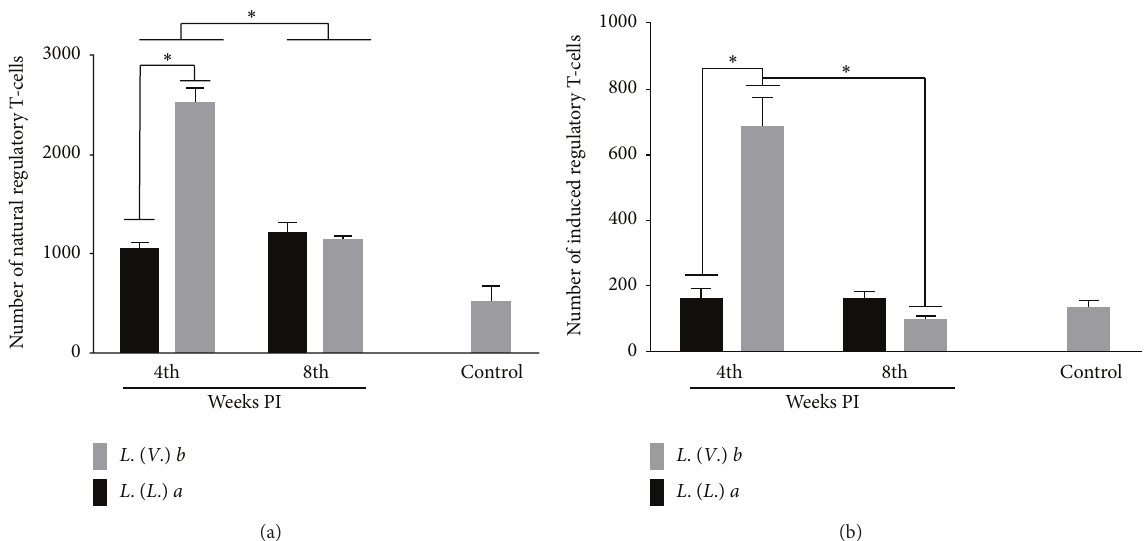
Figure 6: Phenotyping of subsets of regulatory T-cells in the popliteal lymph nodes of BALB/c mice infected with L. (L.) amazonensis or L. (V.) braziliensis . (a) Natural regulatory T-cells (CD4 + CD25 + FOXP3 + ). (b) Inducible regulatory T-cells (CD4 + FOXP3 + ). Data represent the mean ± SD of three independent experiments. ∗ 𝑝 < 0.05